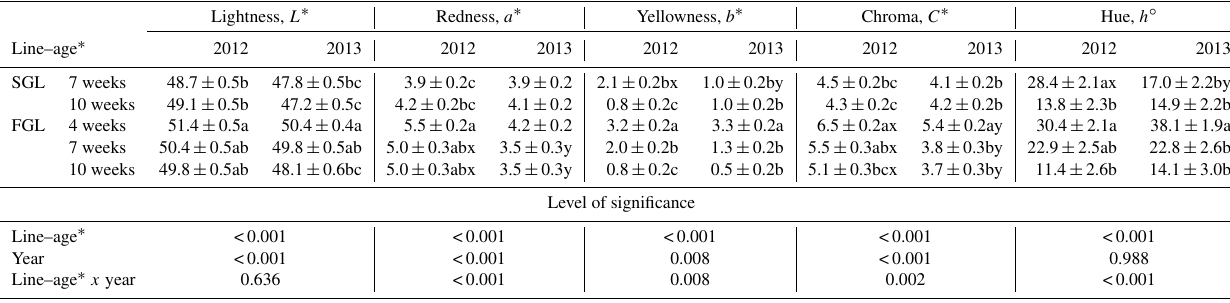
Table 4. Effect of the combination of chicken line, slaughter age, and year on the color of breast meat. Lightness, L ∗ Redness, a ∗ Yellowness, b ∗ Chroma, C ∗ Hue, h